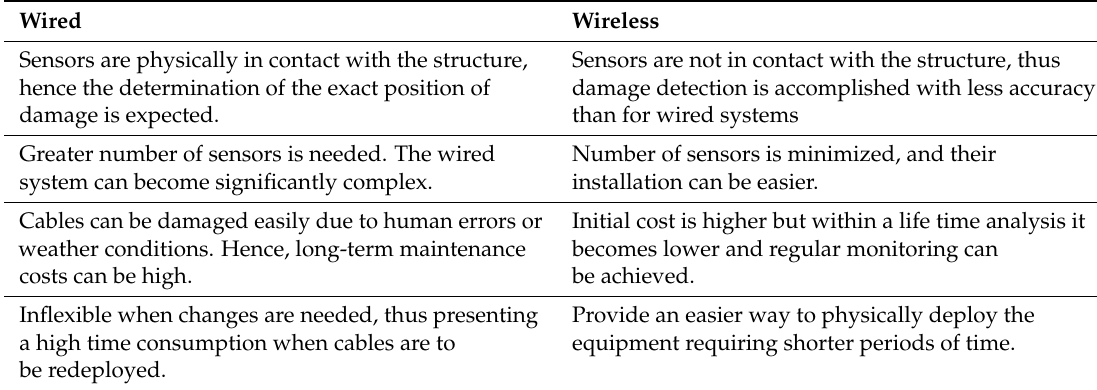
Table 1. Comparison between wired and wireless monitoring